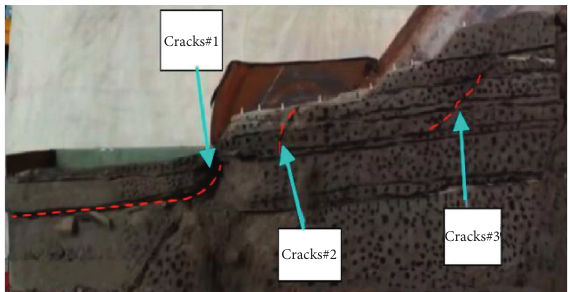
Figure 6: Distribution of cracks in the slope under the input dynamic load with a frequency of